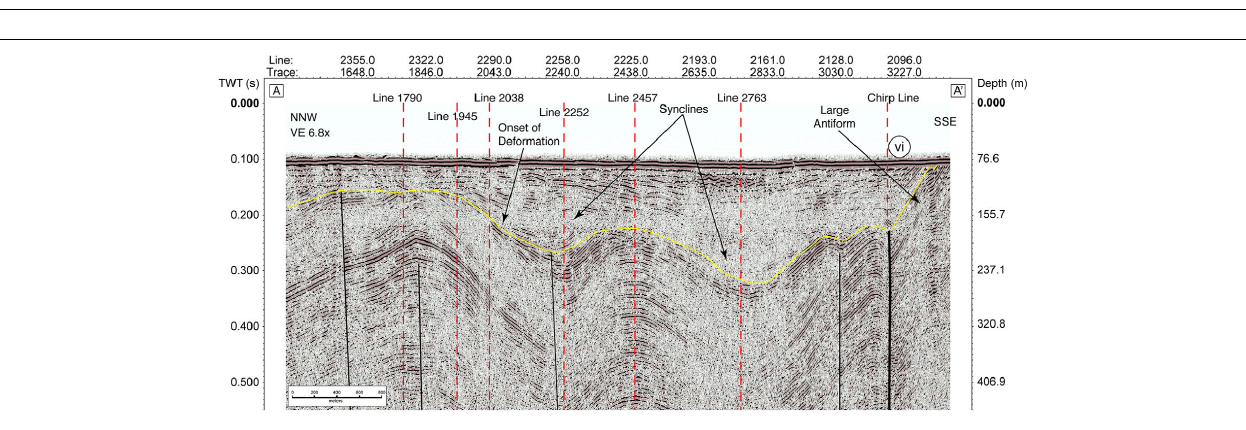
FIGURE 12 | Interpreted arbitrary line across northern section of survey are from A to A’. Location of seismic line is shown in Figure 1C . Minor faults are shown with thin black lines. Major faults are shown with thick black lines and labeled. The view is to the northeast, toward the coastline. Reflector color has been desaturated for ease of interpretation. Red dashed lines trace locations of crosslines shown in previous figures. A sequence of anticlines and synclines is imaged across the arbitrary line, terminating at the northern limb of the large mid-shelf antiform structure